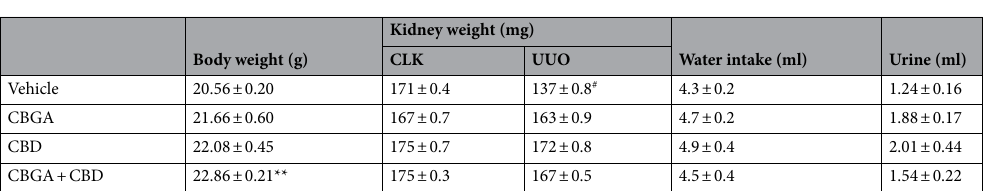
Table 2. Physiological parameters of UUO mice at day 7. Mice were sacrificed at day 7 after surgery and collected CLK and UUO kidneys (n = 4–5). **p < 0.01 vs. vehicle. # p < 0.05 vs correspondent CLK kidney.